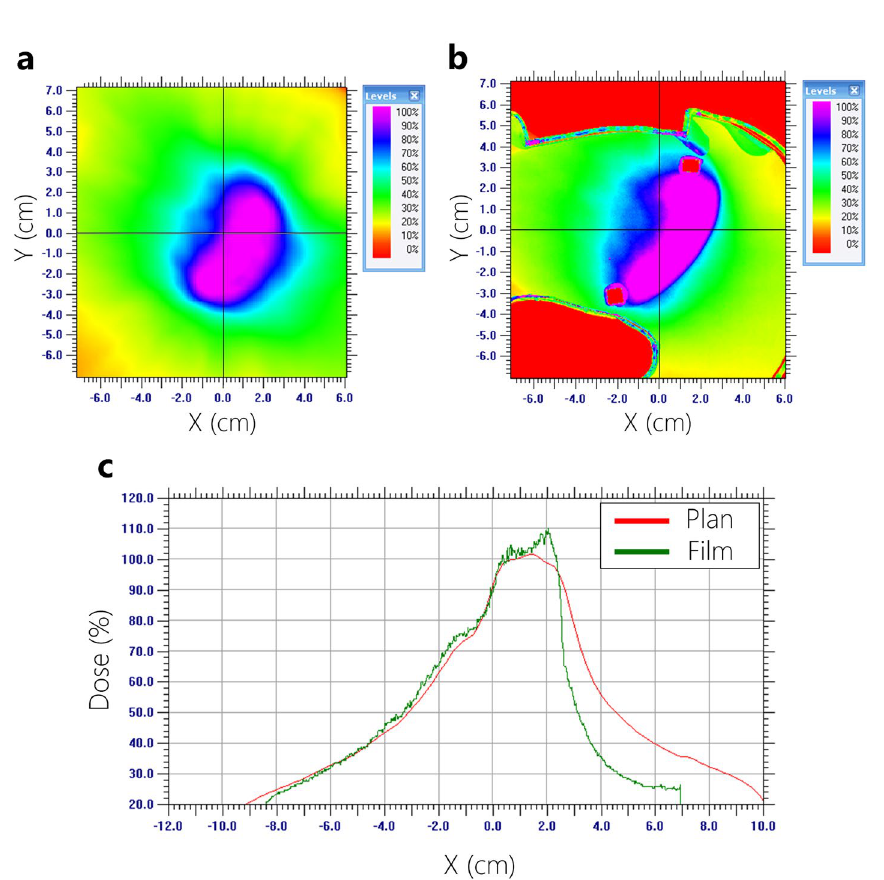
Figure 9. Dose profile analysis (measured film vs. planned dose) using 6-MV based on AAA Algorithm. ( a ) Planned dose, ( b ) measured dose, ( c ) comparison of dose